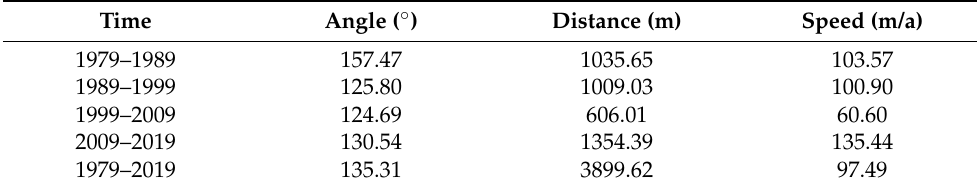
Table 4. Statistics of decadal elliptic center